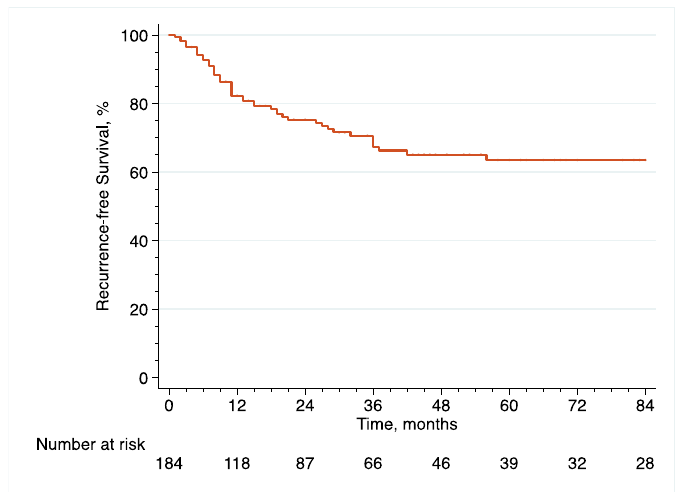
Figure 1. Kaplan–Meier curve that analyses the RFS of included patients treated with eRC for HR- NMIBC.